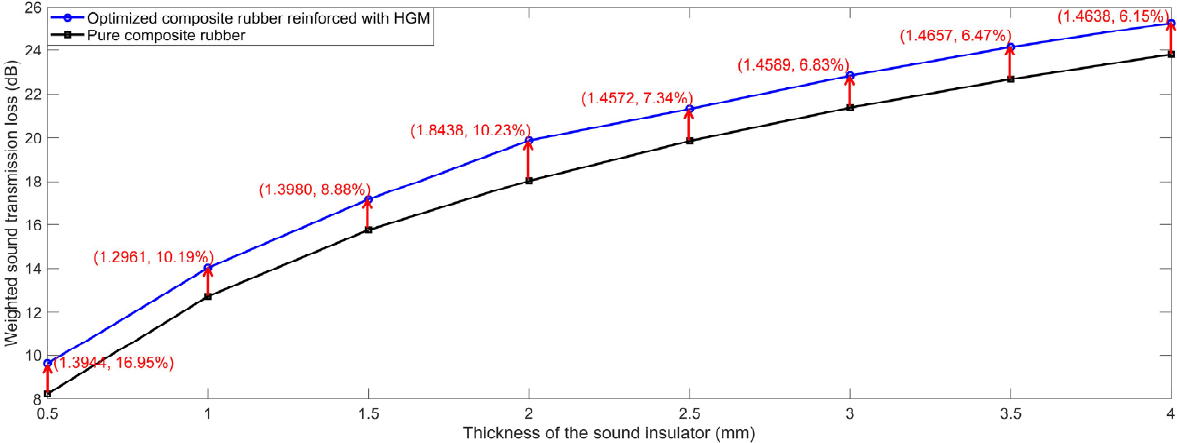
Figure 19. Comparisons of sound insulation performance of pure composite rubber and that of the optimized composite rubber reinforced with HGM.